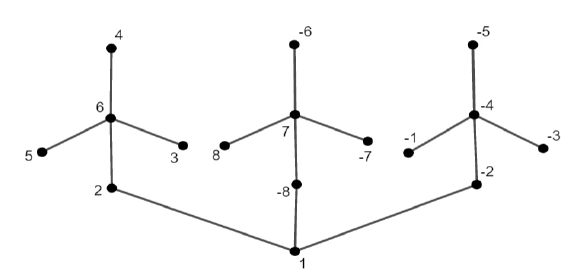
Figure 1: Integer cordial labeling of B